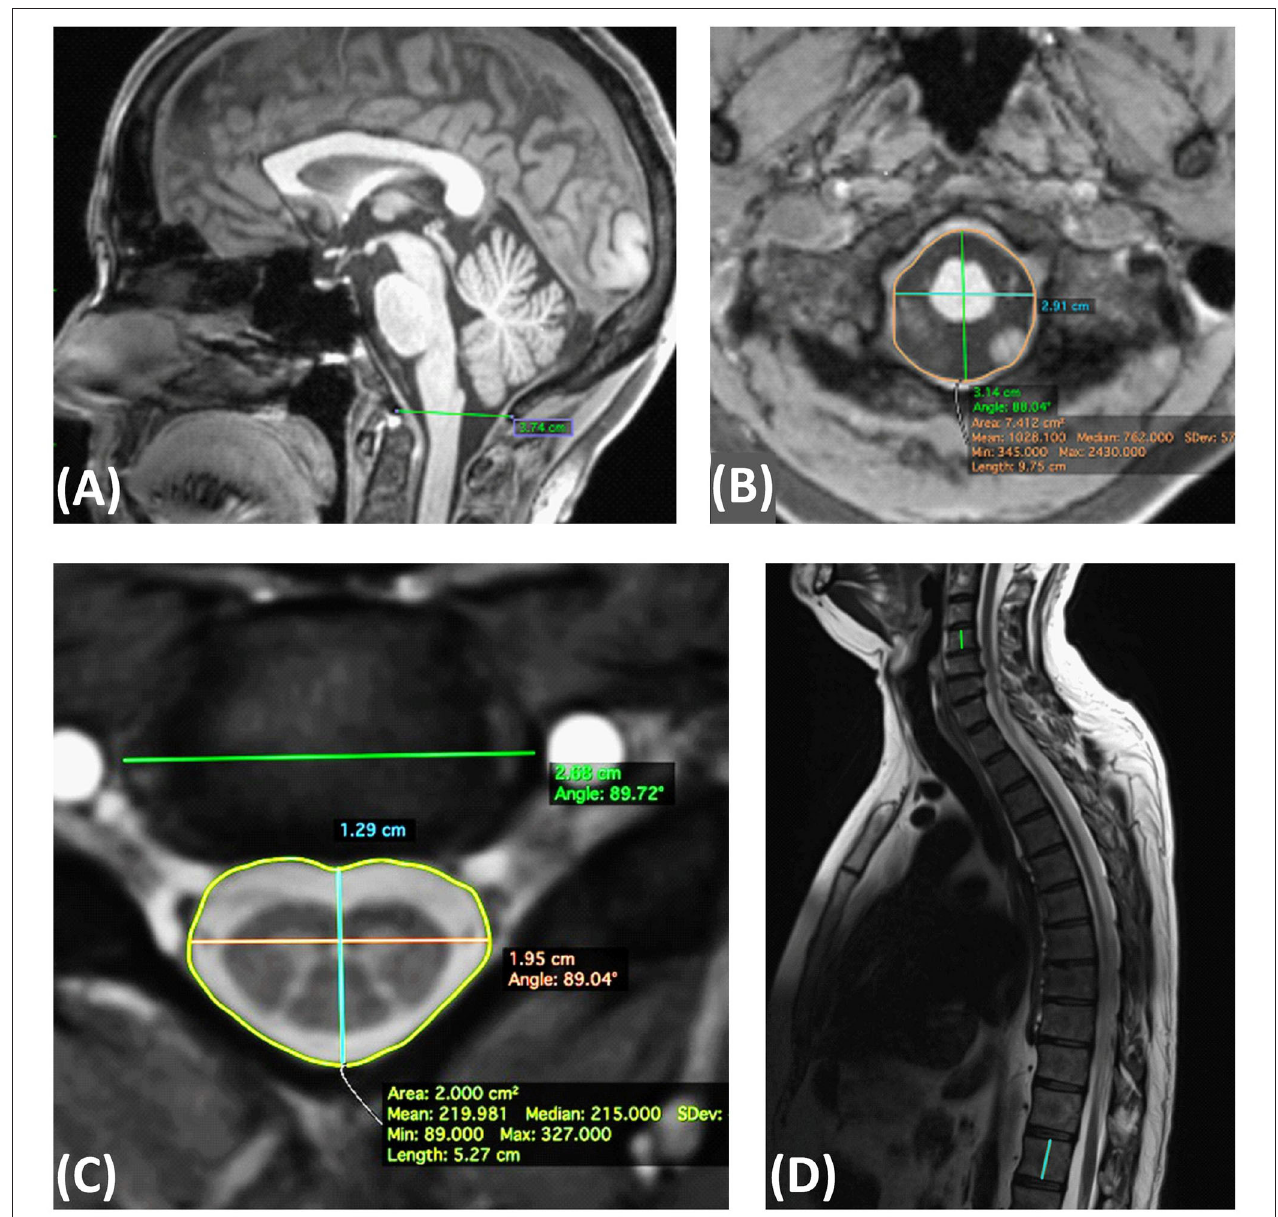
FIGURE 2 | Definition of the skeletal metrics. (A) Sagittal T1 weighted MPRAGE: McRae line (distance between Basion–Opisthion). (B) Axial MPRAGE: anterior posterior and lateral diameters, as well as area of the foramen magnum. (C) Axial rAMIRA: Maximum axial anterior posterior and lateral spinal canal diameters, spinal canal area, maximum lateral vertebral body width. (D) Sagittal T2 weighted turbo spin echo: middle vertebra height C4 and T12.